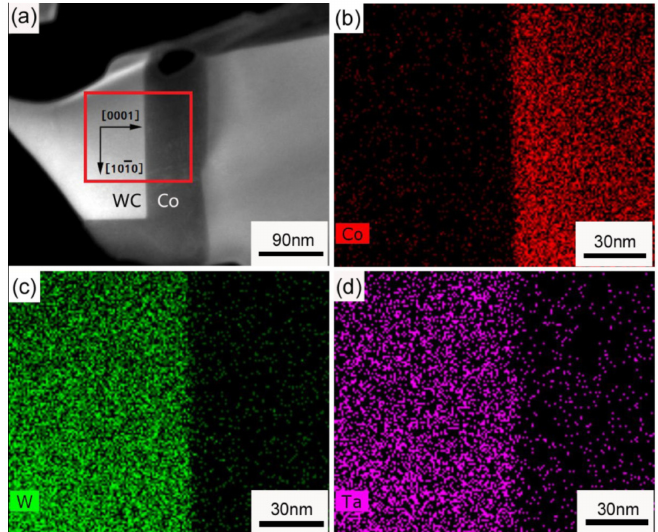
Figure 12. TEM studies of the basal (0001) WC WC / Co interface in sample A4 with 0.8 wt. % TaC. ( a ) High–angle annular dark field (HAADF) image of basal (0001) WC WC / Co interface. ( b – d ) High–resolution energy dispersive X–ray (HREDX) elemental mapping of Co, W, and Ta of the region of ( a ),